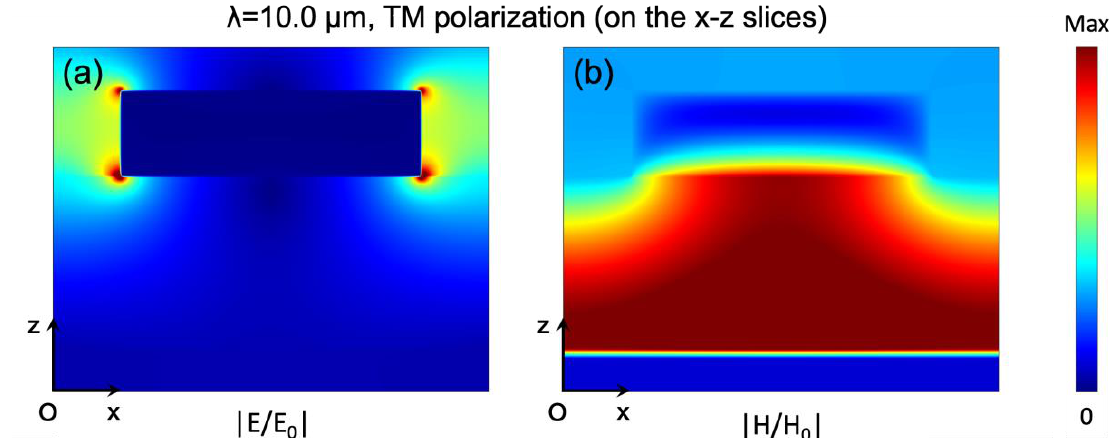
Figure 4. ( a ) Electric field distribution at absorption peak at 10.0 µm under TM-polarized light; ( b ) magnetic field distribution at absorption peak at 10.0 µm under TM-polarized light.